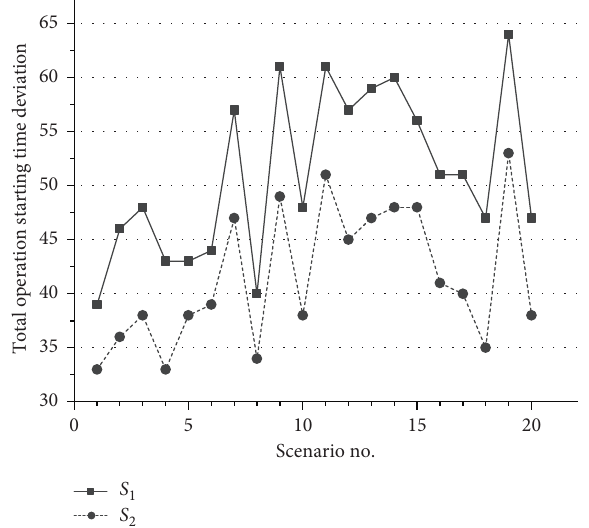
Figure 6: The total operation starting time deviation of S